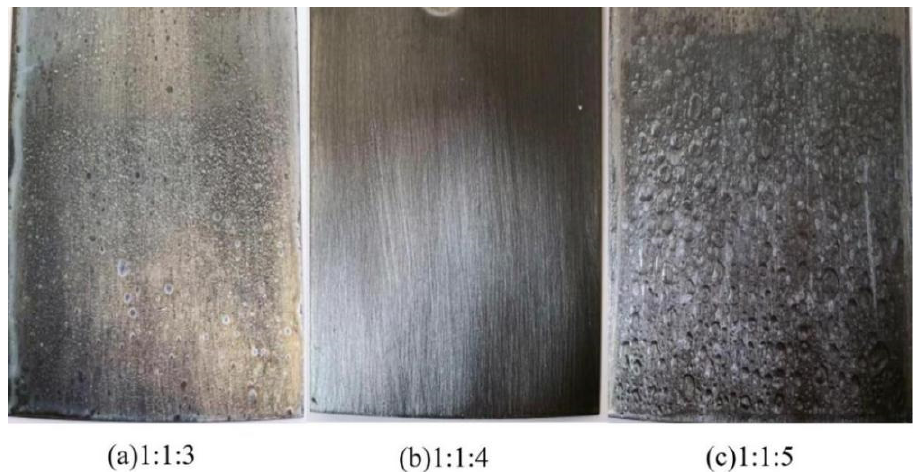
Figure 7. Characterization diagram of acid resistance of cured films with different MXDA content